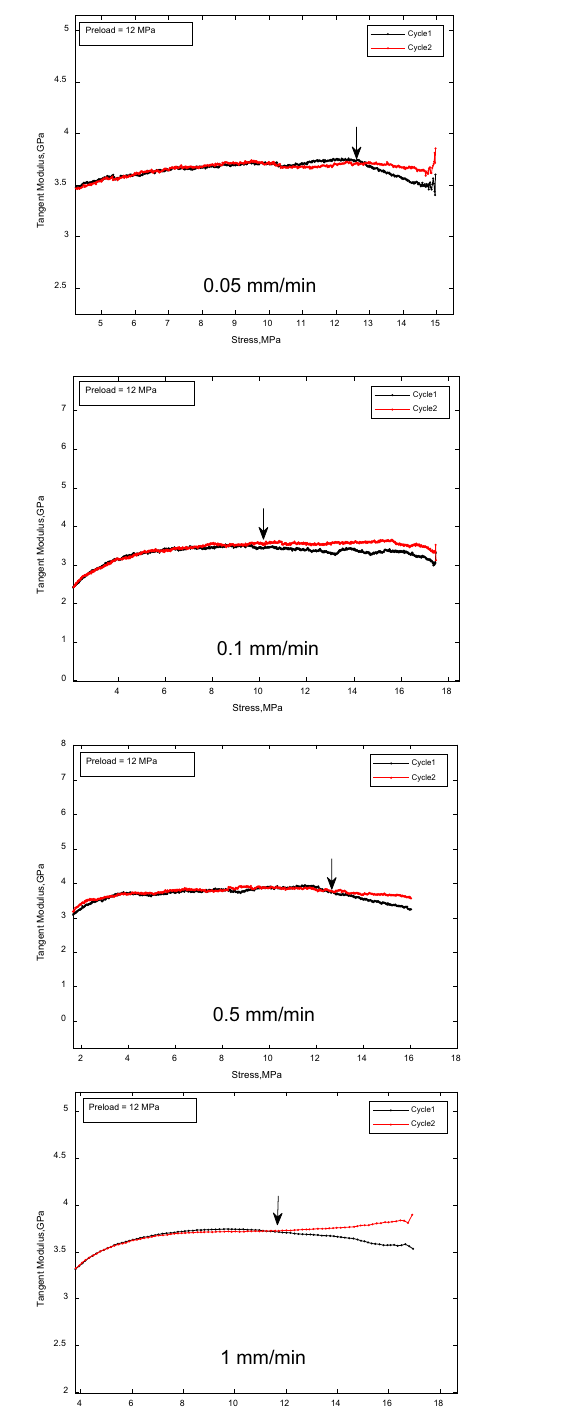
Fig. 13 Scatter plot of the measured stresses against applied stresses at different loading/displacement